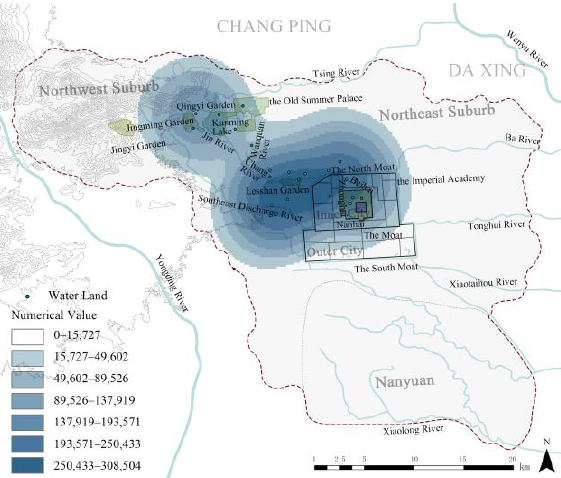
Figure 11. Spatial distribution and density analysis map of water land.